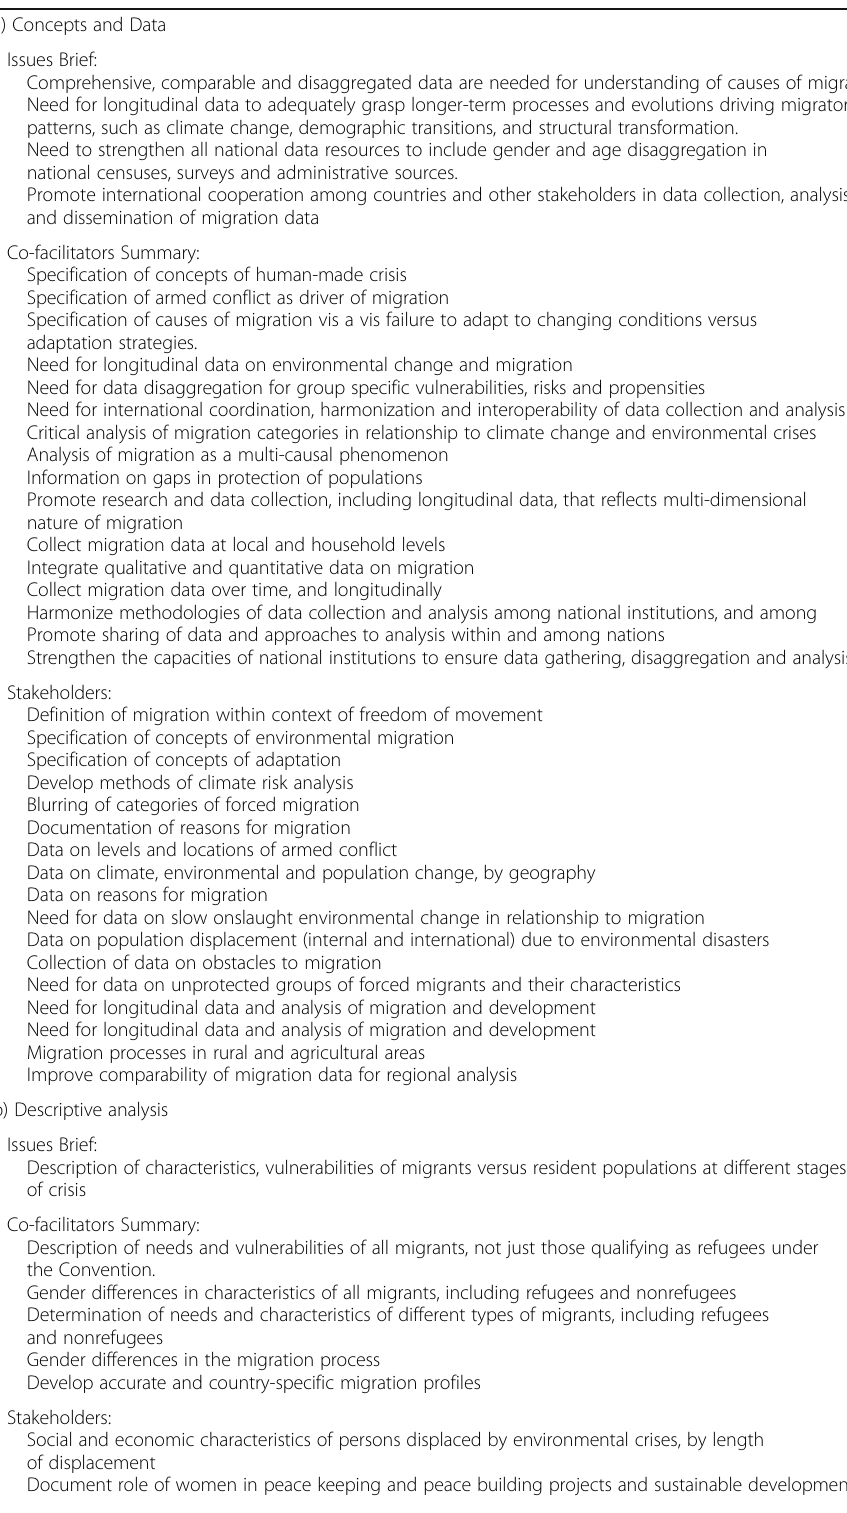
Table 2 Proposals for data and research: Thematic Session II Addressing drivers of migration, including adverse effects of climate change, natural disasters and human-made crises, through protection and assistance, sustainable development, poverty eradication, conflict prevention and